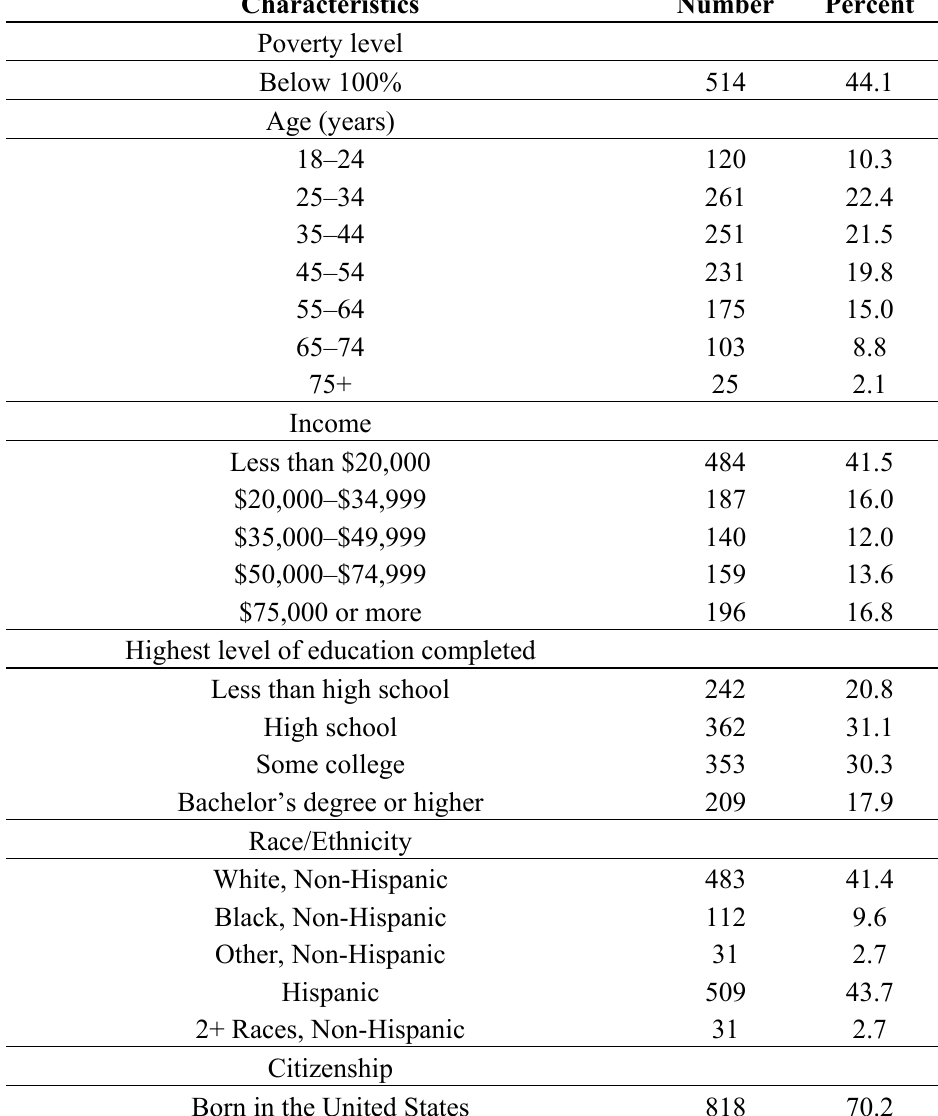
Table 1. Socio-demographic profile of sample ( n =